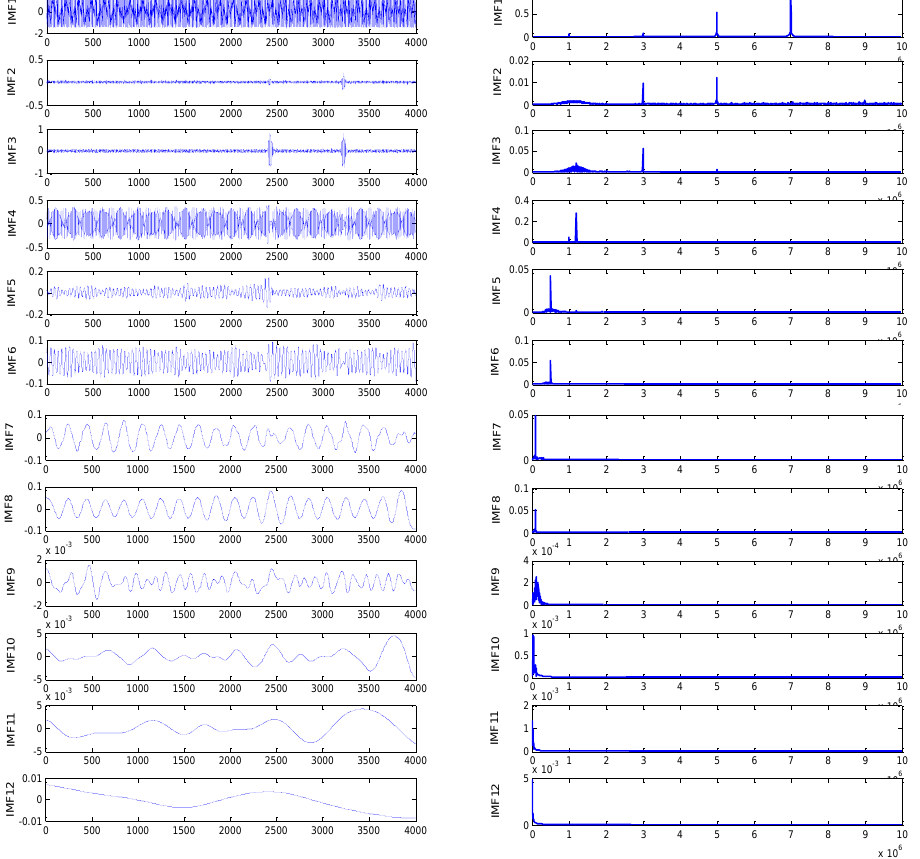
Figure 4. Intrinsic mode functions (IMFs) obtained by complete ensemble empirical mode decomposition with adaptive noise (CEEMDAN): time domain waveforms ( left ) of each IMFs and its corresponding frequency domain waveform ( right ).